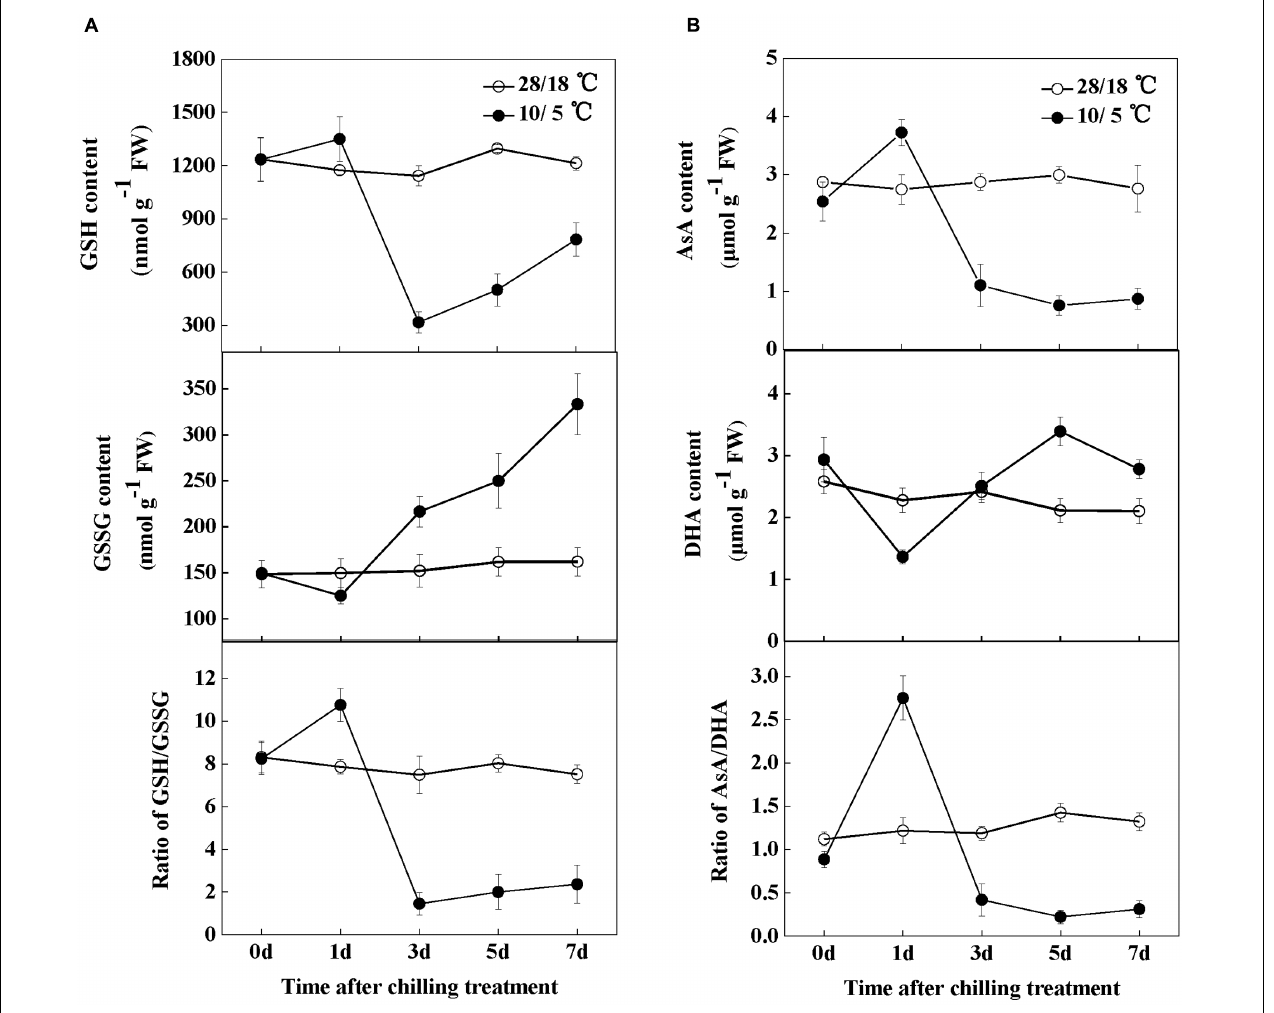
FIGURE 5 | Changes in glutathione and ascorbate homeostasis in response to chilling stress in watermelon plants. (A) Changes in glutathione homeostasis. (B) Changes in ascorbate homeostasis. Leaf samples were collected at the indicated times. The data are the means of four replicates with